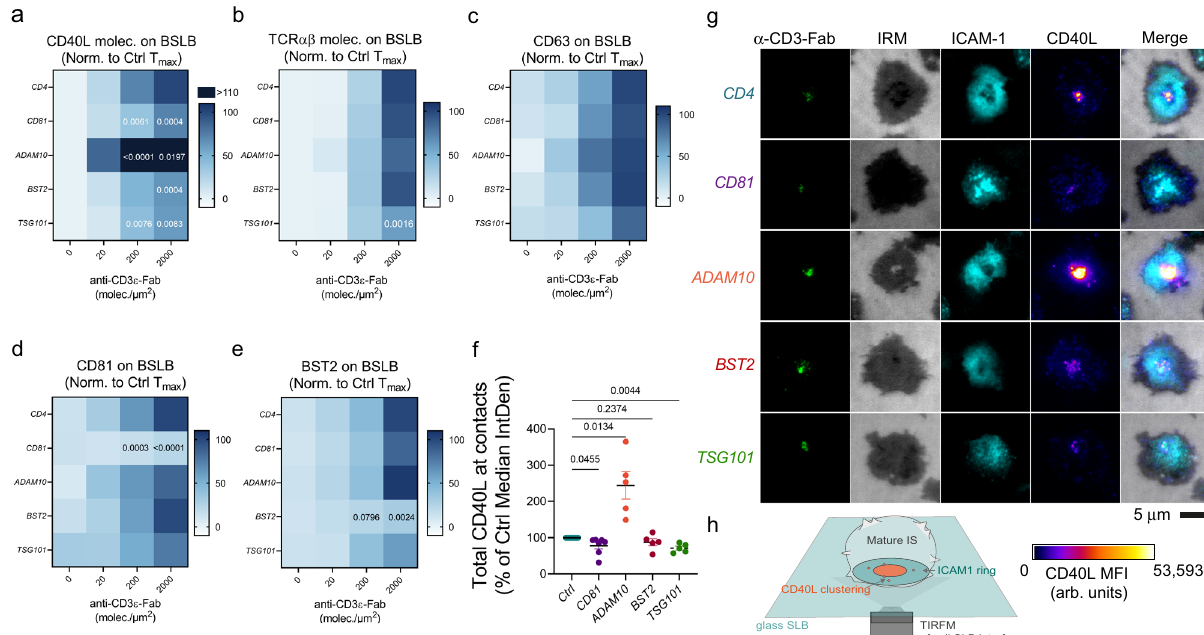
Fig. 5 ADAM10, TSG101, CD81, and BST2 are key proteins participating in the biogenesis of CD40L + tSV. a – e Flow cytometry analyses showing the transfer of tSV markers to BSLBs expressed as percent of the maximum transfer (Tmax%) observed in BSLBs co-cultured with CD4 -edited controls. BSLBs were reconstituted with ICAM1 (200 molec./ µ m 2 ), CD40 (20 molec./ µ m 2 ) and anti-CD3 ε Fab (0 – 2000molec./ µ m 2 ). Please refer to Supplementary Fig. 1a for a representative gating strategy showing the identi fi cation of single BSLBs and T cells by fl ow cytometry. a Heatmaps showing Tmax% for CD40L, b TCR αβ , c CD63, d CD81, and e BST2 in BSLB incubated with different CRISPR/Cas9-edited cells (gRNA gene targets shown in italic). f TIRFM quanti fi cation of normalized medians for the integrated fl uorescence intensities of CD40L within synapses formed by CRISPR/Cas9-edited cells. Circles represent the integrated fl uorescence median per donor and per CRISPR/cas9 target normalized to its internal control (teal). CD81- (violet circles), ADAM10- (orange circles), BST2- (dark red circles), and TSG101 -edited cells (green circles) were imaged with TIRFM. g Representative TIRFM images ( g ) showing the levels of centrally clustered CD40L in synapses of CRISPR/Cas9-edited cells imaged as depicted in h and compared with CD4 -edited controls. Scale bar = 5 µ m. MFI = Mean Fluorescence Intensity, arb. units = arbitrary fl uorescence units. IRM = internal re fl ection microscopy. Data are shown as means ± SEM from n = 10 ( a – e ), and 7 ( f ) biologically independent samples (donors) across fi ve independent experiments. In a – e , normality was determined using Shapiro – Wilk test, and statistical signi fi cance was determined by parametric two-tailed Multiple t test with Holm- Š ídák correction ( α = 0.05) for the multiple comparisons of Tmax% across different anti-CD3 ε Fab densities and between CRISPR/Cas9-edited cells and CD4 -edited controls ( a – e ), and by one-way ANOVA with mixed-effect analysis and Fisher ’ s LSD test (95% CI) to compare separately each CRISPR/Cas9-edited cells to controls ( f ). Values represent calculated P values for each comparison to